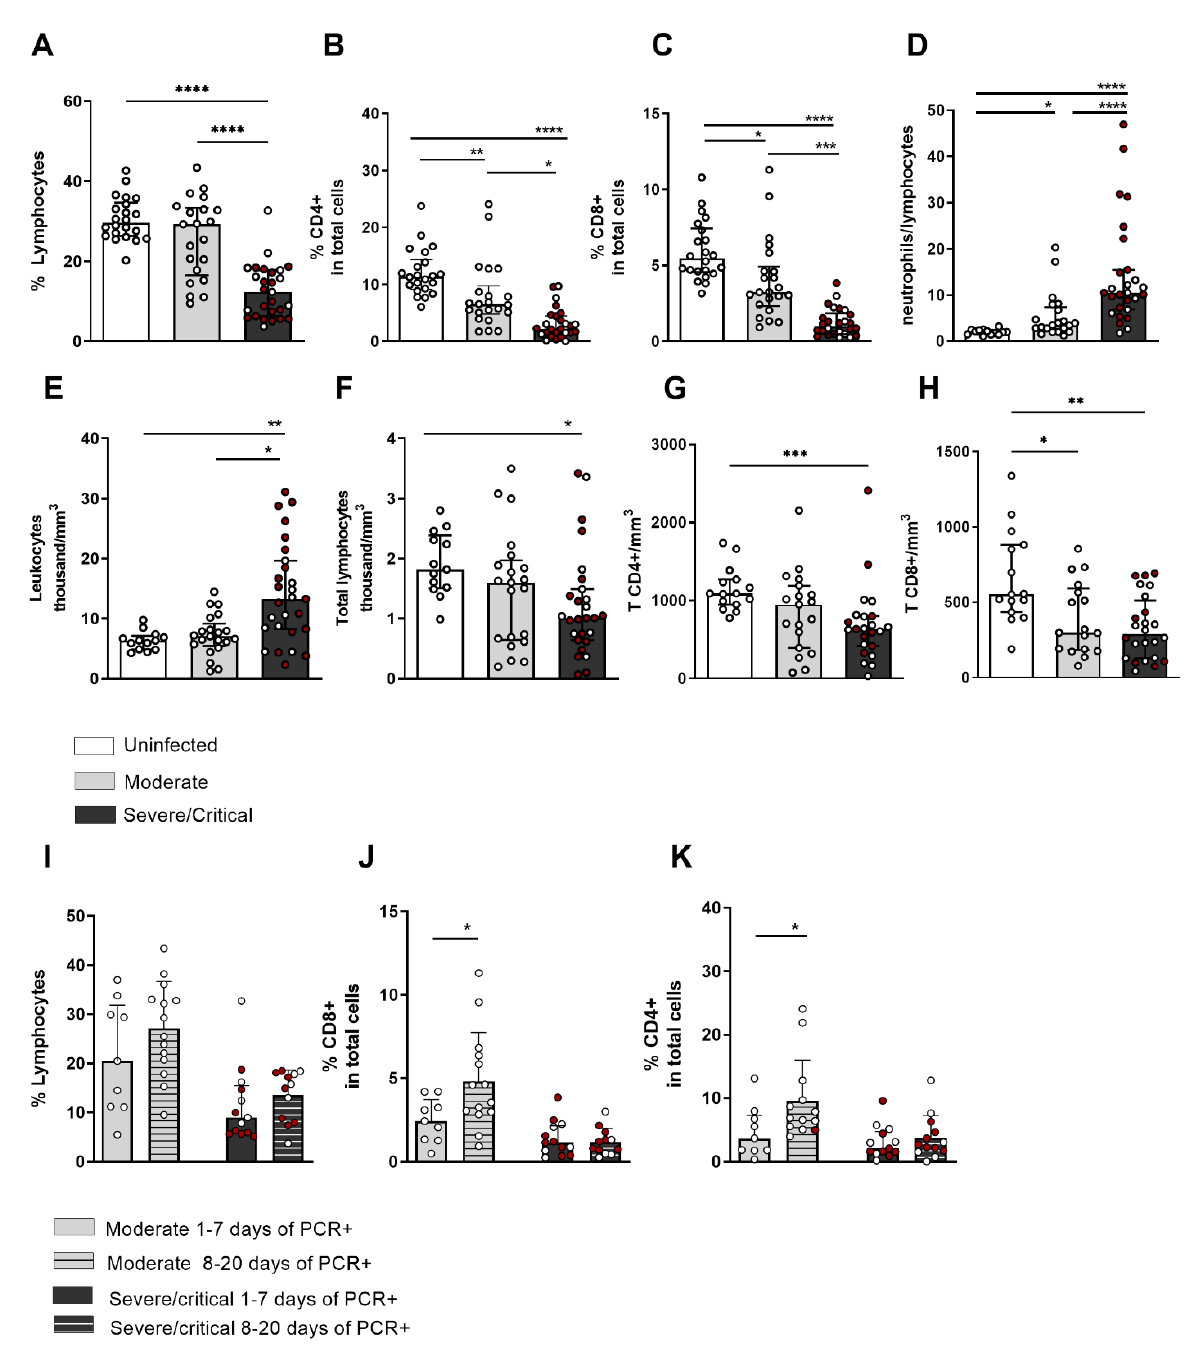
Figure 2. Decreased numbers of CD4+ and CD8+ T lymphocytes in patients with severe/critical dis- ease from SARS-CoV-2 infection. The graphs show the frequency of cells within living cells: ( A ) total T lymphocytes, ( B ) CD4+ T lymphocytes, ( C ) CD8+ T lymphocytes, ( D ) neutrophil/lymphocyte ratio (NLR), ( E ) leukocyte number (thousand/mm 3 ), ( F ) total lymphocyte number (thousand/mm 3 ), ( G ) total number of CD4+ T lymphocytes per mm 3 , ( H ) total number of CD8+ T lymphocytes per mm 3 , ( I – K ) frequency of CD4 and TCD8 T lymphocytes from SARS-CoV-2-infected patients with moderate or severe critical disease between 1–7 days positive and 8–20 days positive PCR. Red dots represent patients with critical infection. The bars represent the median and interquartile range. * p < 0.05, ** p < 0.01, *** p < 0.001, and **** p <